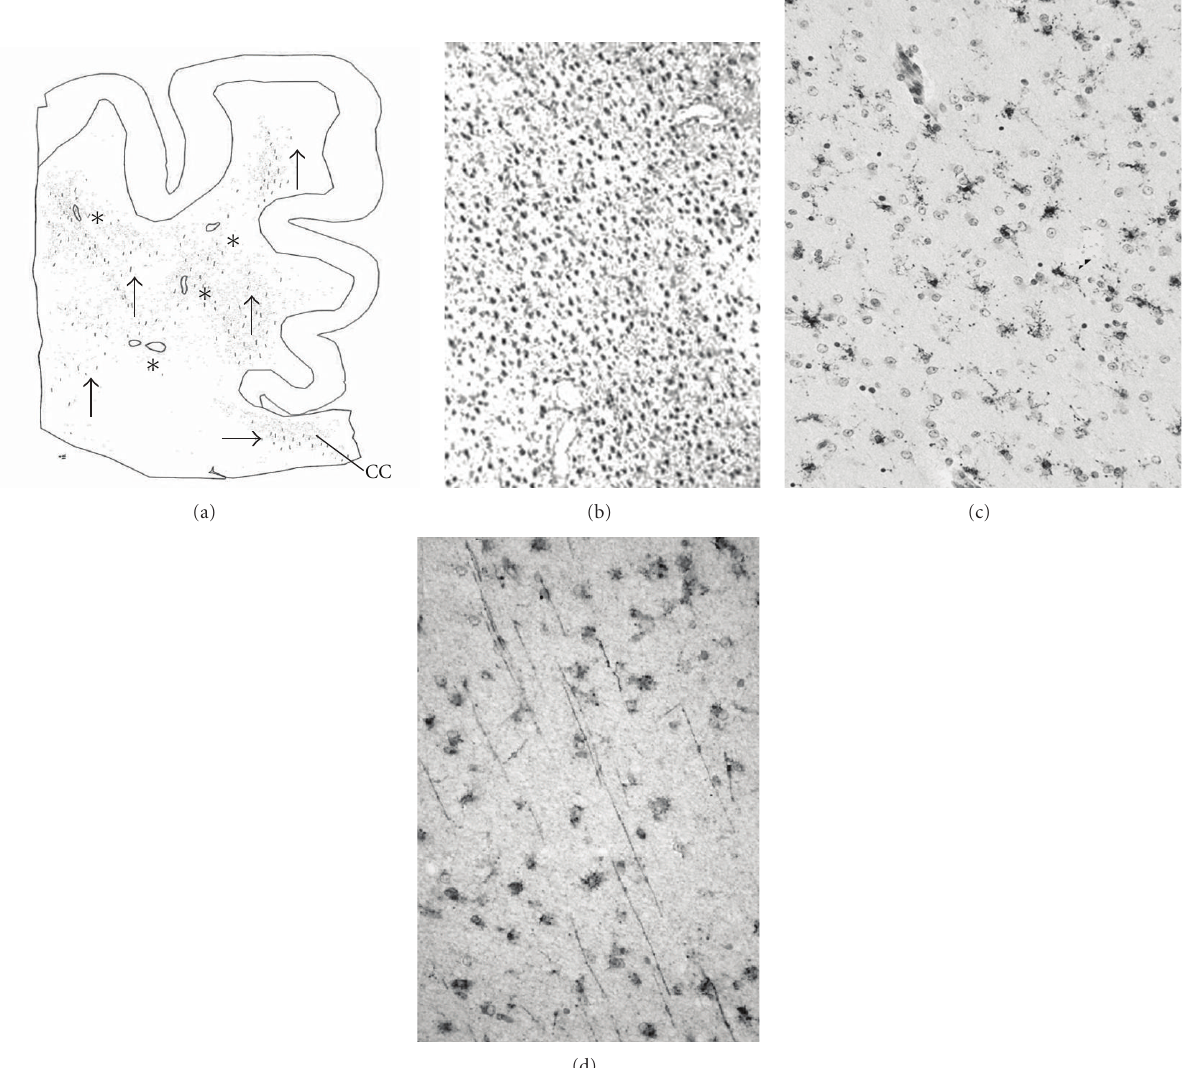
Figure 1: White matter damage in the human preterm brain is characterized by microscopic foci of necrosis and di ff use reactive gliosis, microglial activation, and axonal damage. (a) Camera lucida drawing of the distribution of microcysts ( ∗ ) and axonal fragments (arrows) in the posterior frontal white matter (level of the body of the corpus callosum [CC]). In the white matter distant from periventricular foci of necrosis is reactive gliosis, as demonstrated by the immunomarker glial fibrillary acidic protein (b), microglial activation, as demonstrated by the immunomarker CD68 (c), and axonal injury, as demonstrated by the immunomarker fraction